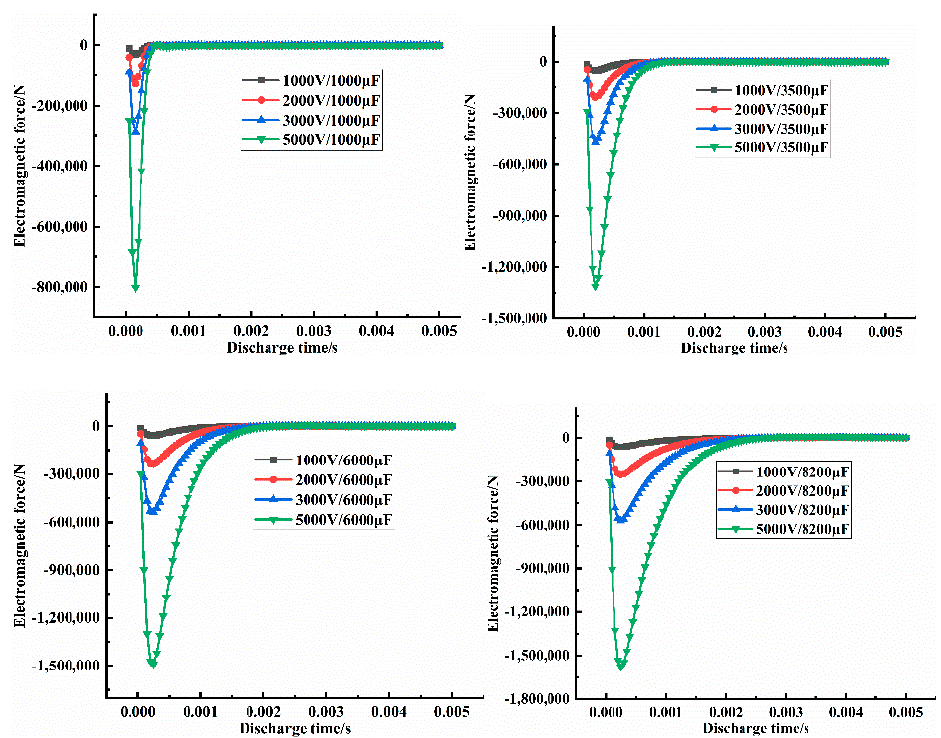
Figure 11. The different voltage influence on electromagnetic force.